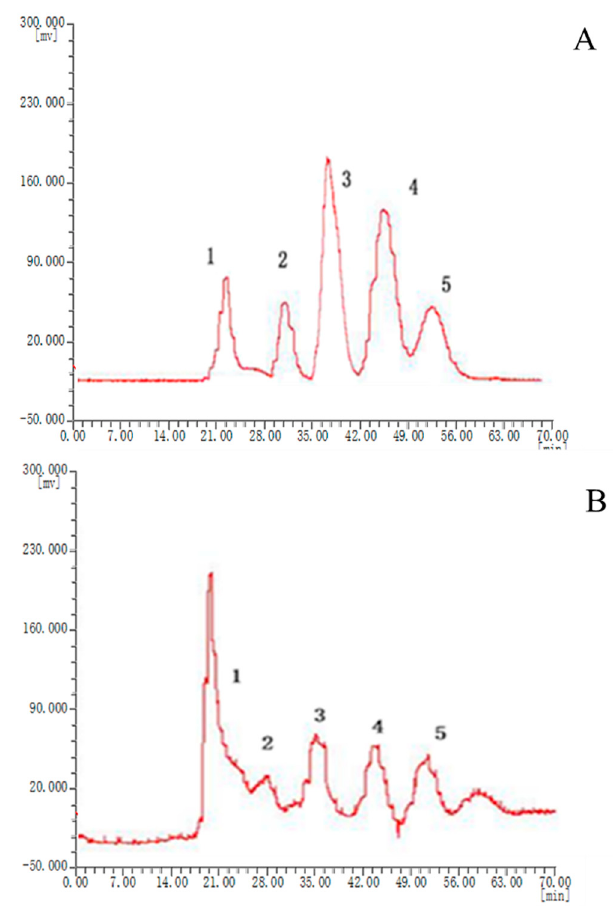
Figure 2. High-speed countercurrent chromatography (HSCCC) chromatogram of Psoralea corylifolia L. A : HSCCC chromatogram of standard compounds. B : HSCCC chromatogram of the